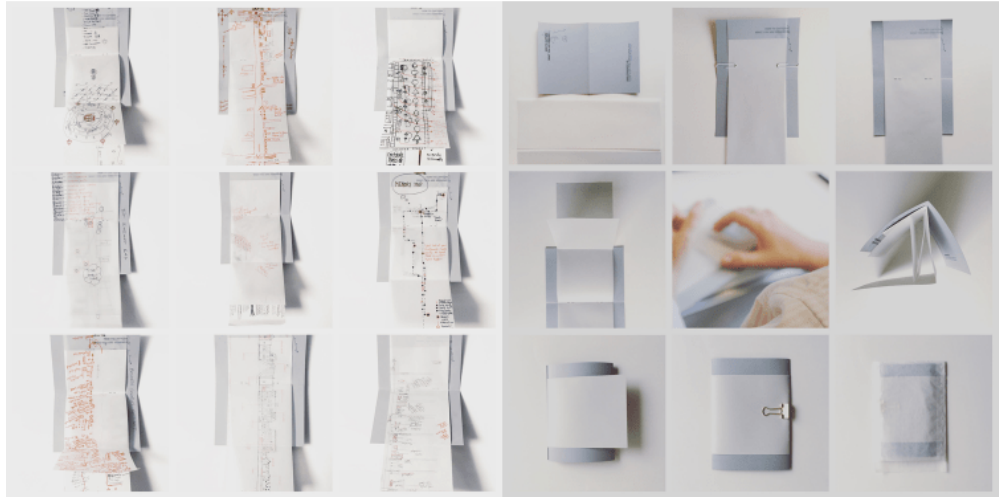
Fig. 7 Genz, G, 2017. (ON LEFT) Ethnography in Urban Settings . (ON RIGHT) Fold-Up Mapping Booklet . Retrieved September 21, 2021, from the Urban Ethnography Lab <https:// urban-ethnography.com/methods/